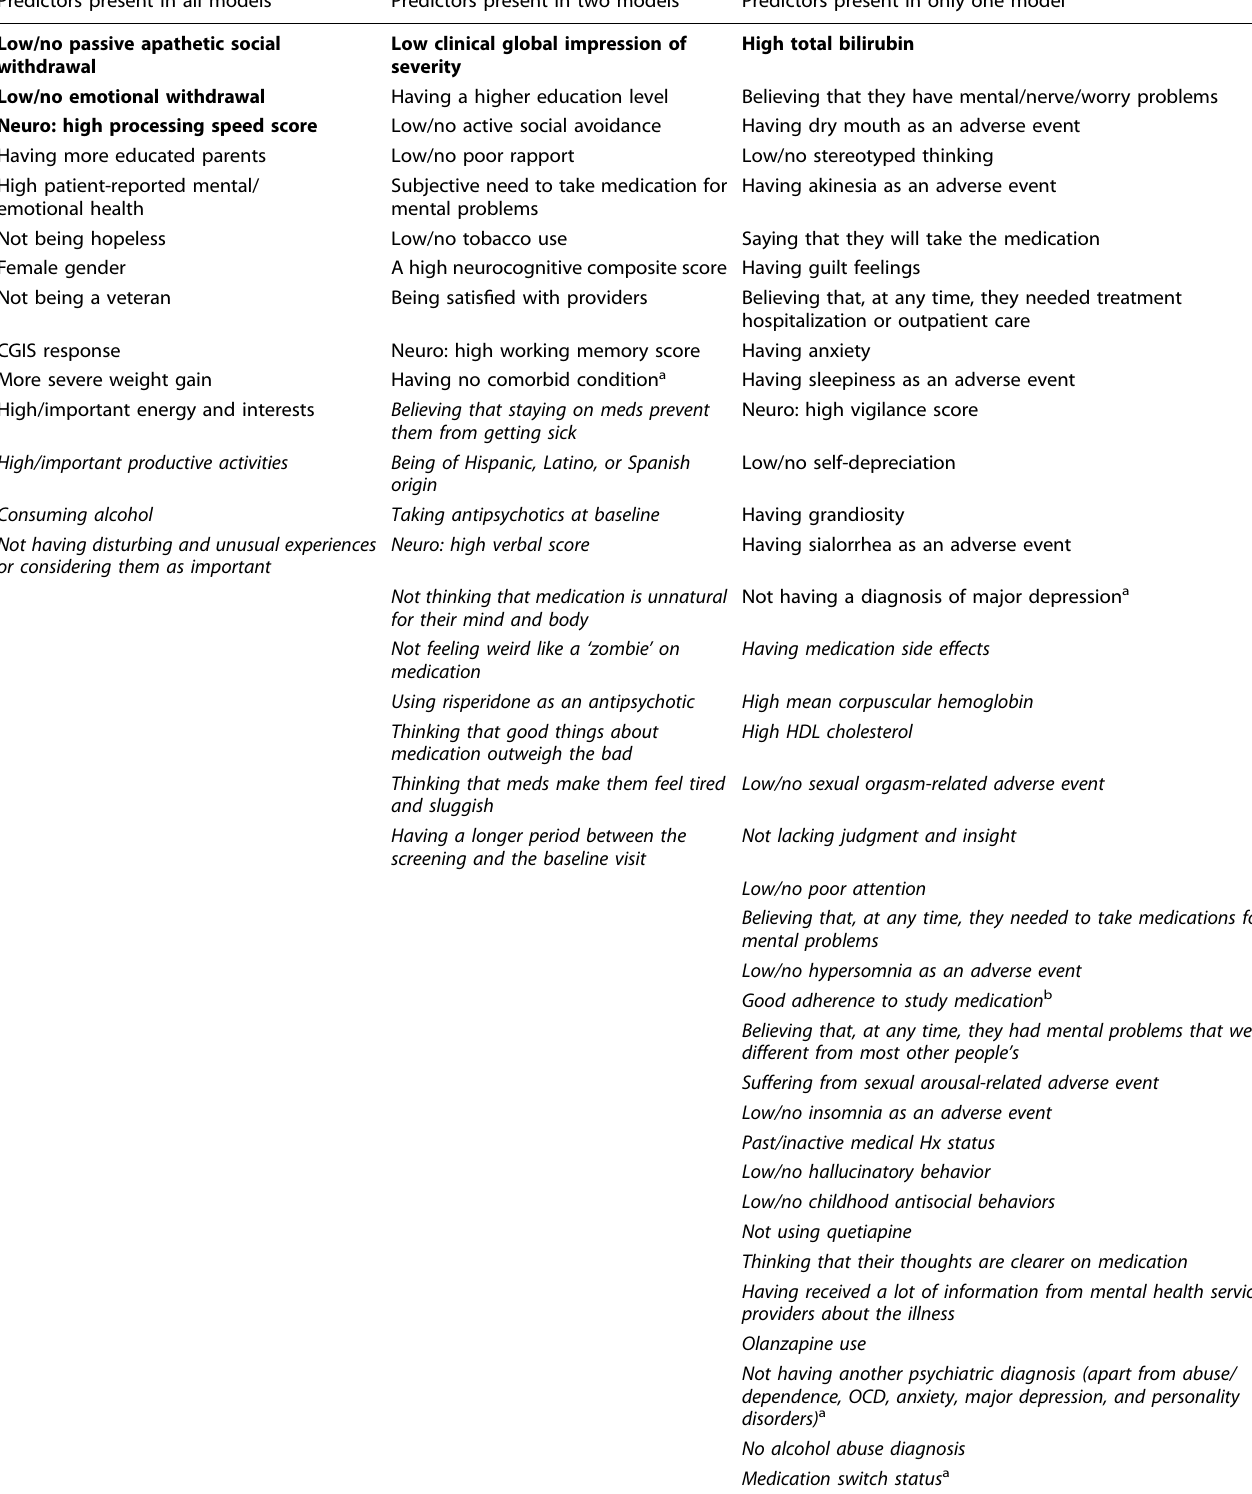
Table 5. Summary of variables favoring quality of life. Variables with a similar meaning (e.g., different scales for the same side effect) were merged. Predictors are presented in order of effect